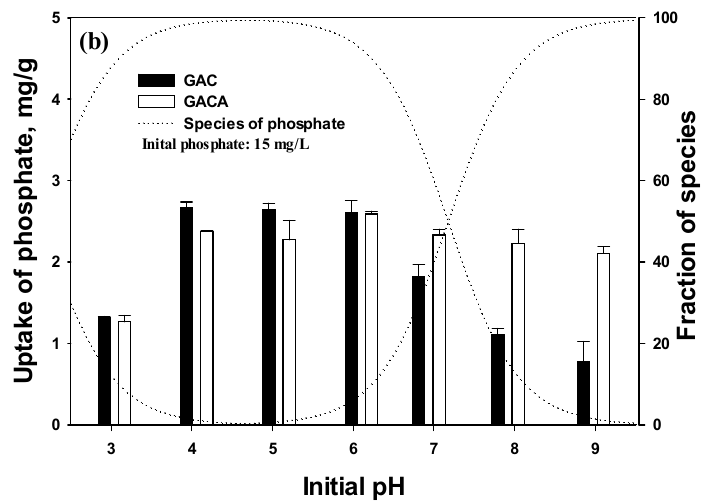
Figure 3. The removal efficiency of phosphate and final pH ( a ) and uptake and fraction of species of phosphate at initial pH of 3–9 ( b ).